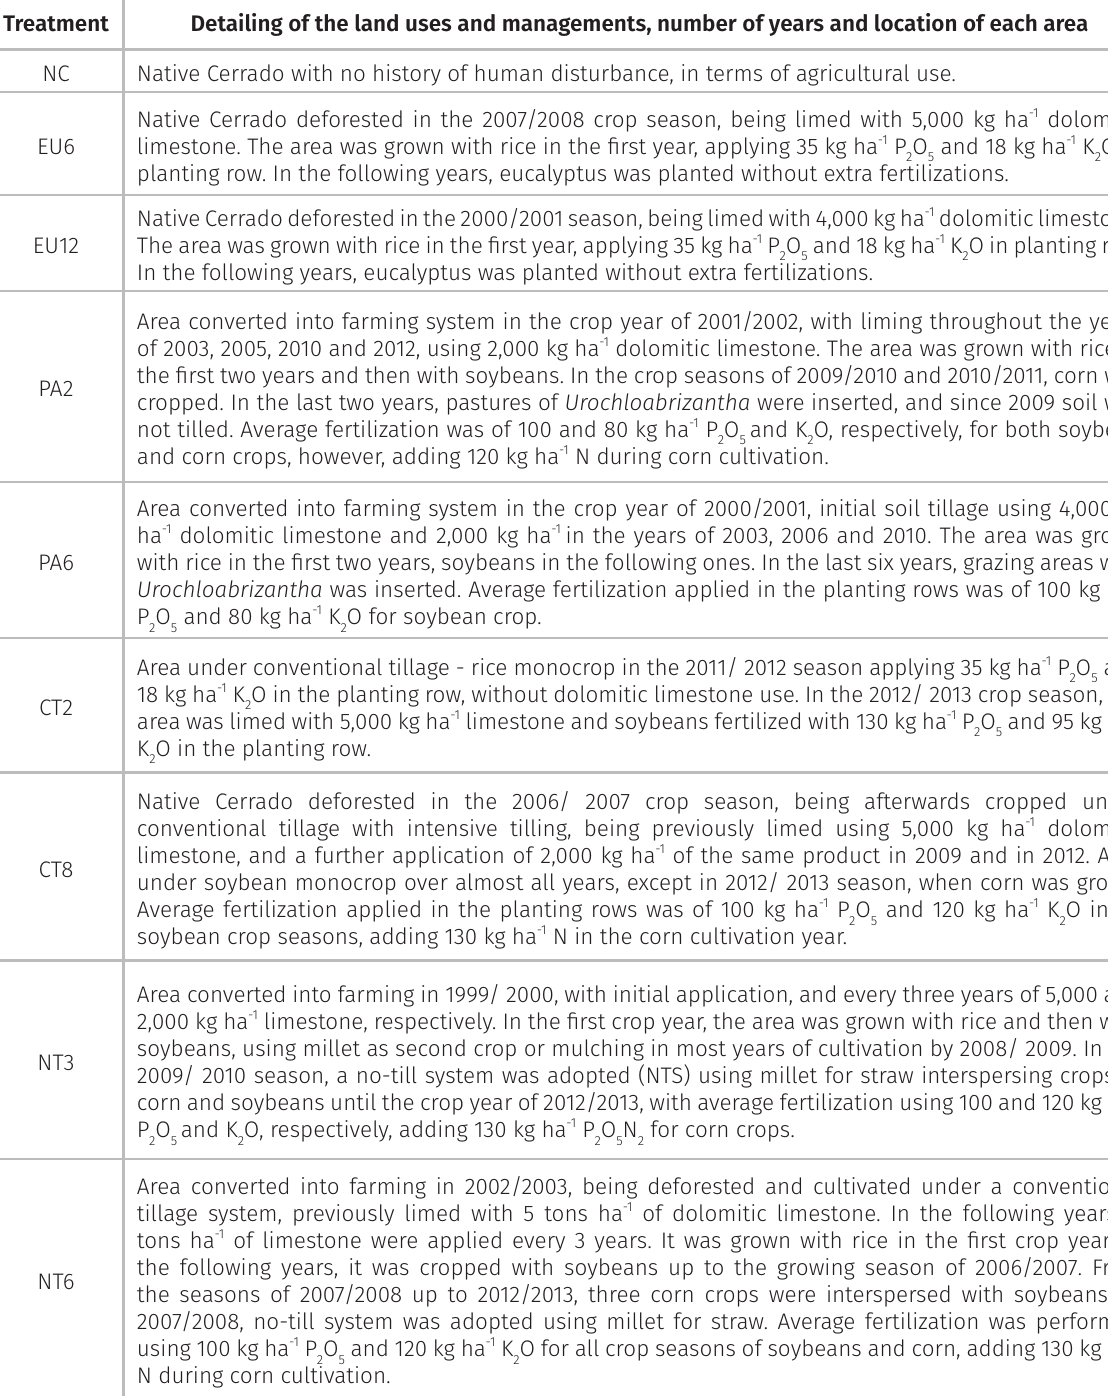
Table I. History of a medium-textured soil from Cerrado (Savana), after several years of different land uses and soil management systems.